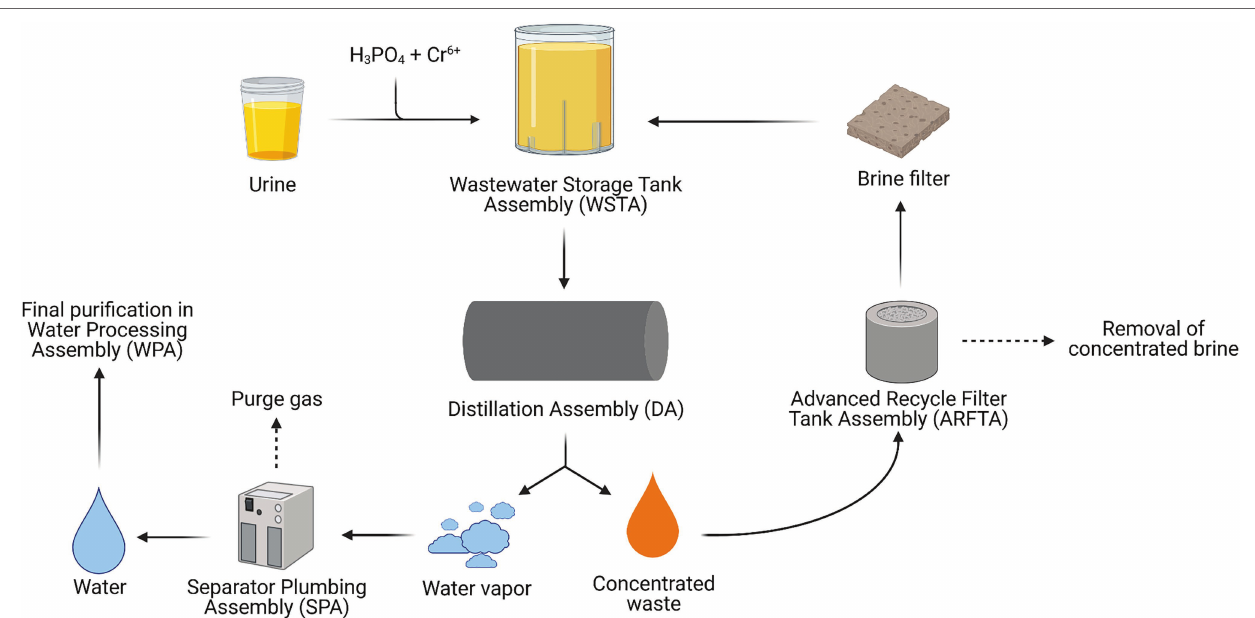
FIGURE 2 | Schematic overview of the Urine Processor Assembly (UPA) module of the Water Recycling System (WRS) operating on the International Space Station (ISS; Adapted from Bagdigian et al.,